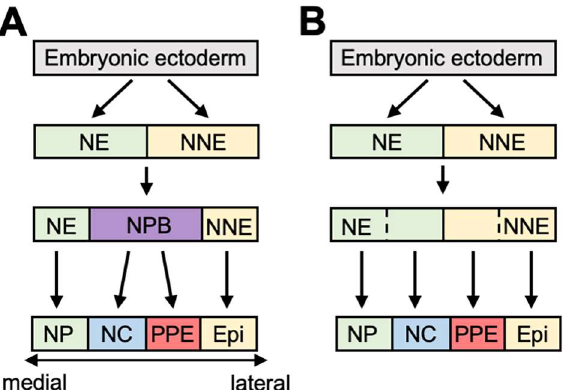
Figure 2. A model of PPE and NC formation: ( A ) the neural plate border (NPB) model; Before division of the NC and the PPE, the NPB region is formed between the neuroectoderm and the non-neural ectoderm; ( B ) binary competence model; The NC is derived from the neuroectoderm, whereas the PPE is from the non-neural ectoderm.